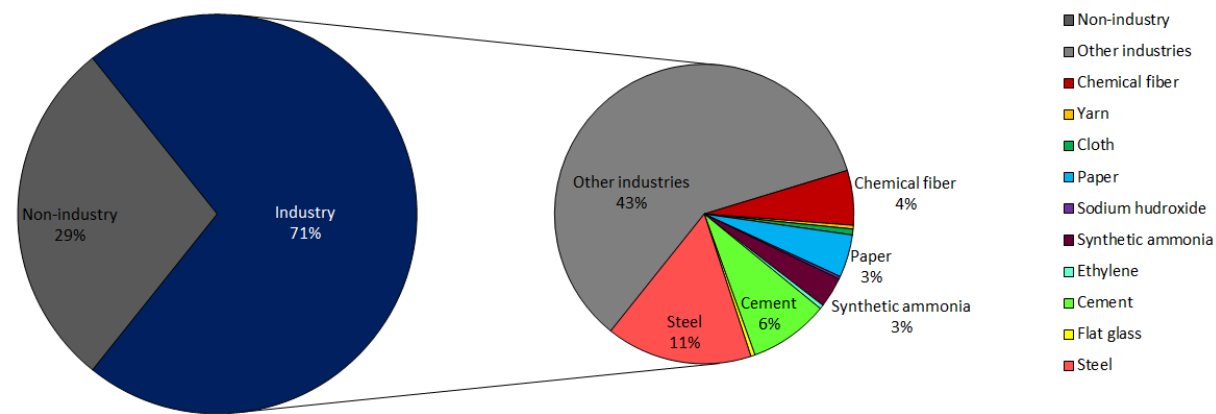
Figure 6. Industrial energy consumption of China, 2009 (Data source: [1]).